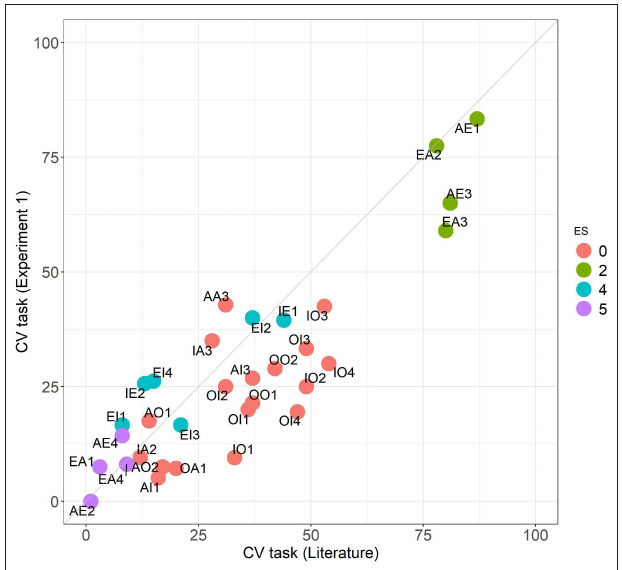
FIGURE 1 | Comparison of the CV task performance across the 32 problems between the literature and Experiment 1 groups. Colors follow the ES